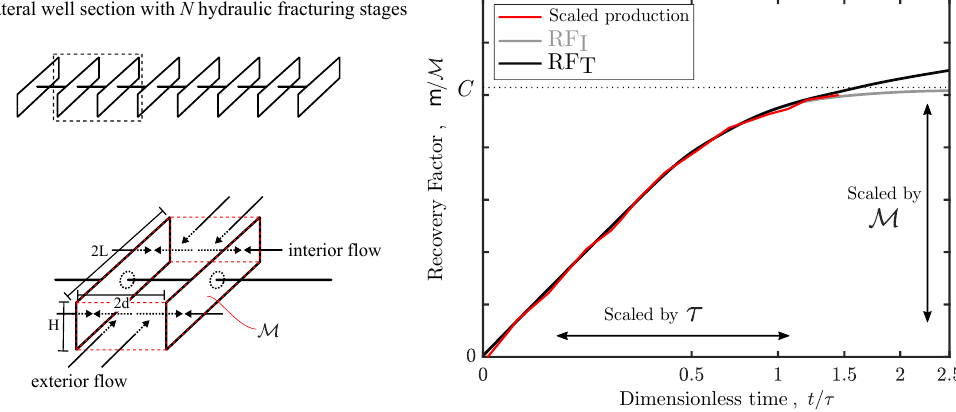
Figure A1. Simple model and Illustration of physical scaling method (adopted from [9]).